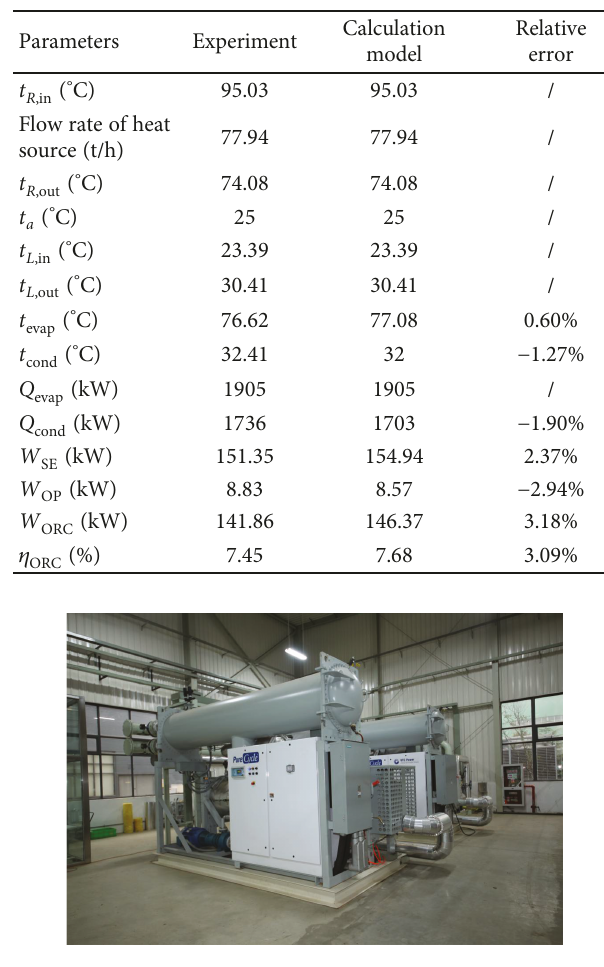
Figure 6: The experimental site of the ORC thermal power plant of the